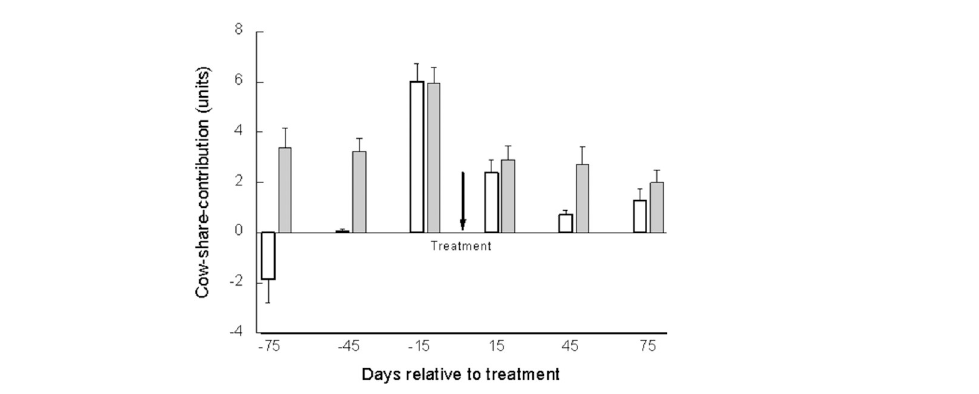
Fig 5. Cow-share-contribution of somatic cells to the bulk milk tank. Mean and SE of cow-share-contribution of somatic cells to the bulk milk tank relative to time of treatment (t = 0) during the first 75 d post-treatment of 103 APT separately for first elevation sub-group ( □ ) (n = 64) and for the chronic sub-group cows ( □ ) (n = 52). Arrow indicates time of treatment.